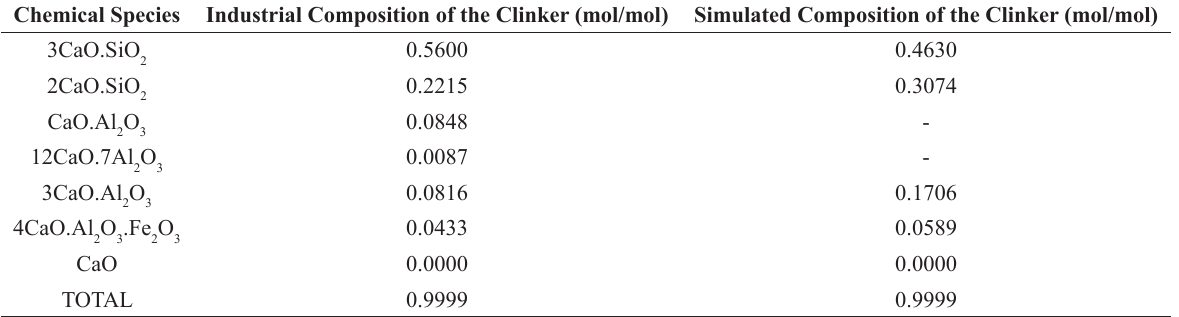
Comparison of the results obtained by the model and the industrial composition of the clinker. Chemical Species Industrial Composition of the Clinker (mol/mol) Simulated Composition of the Clinker